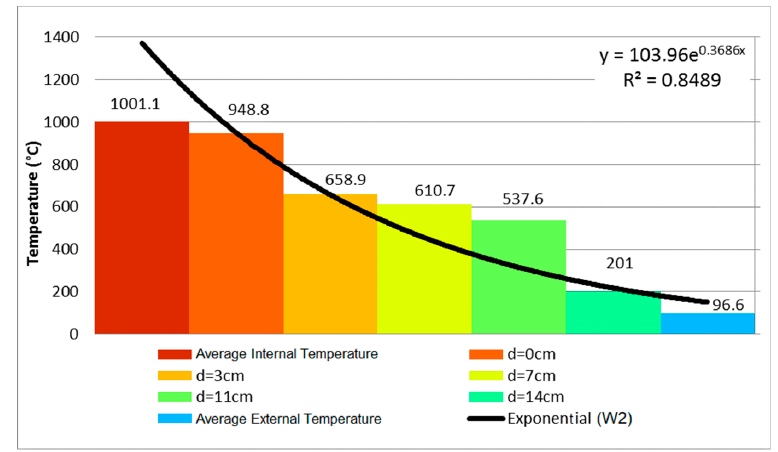
Figure 9. Temperature profile at 102 min—W2.